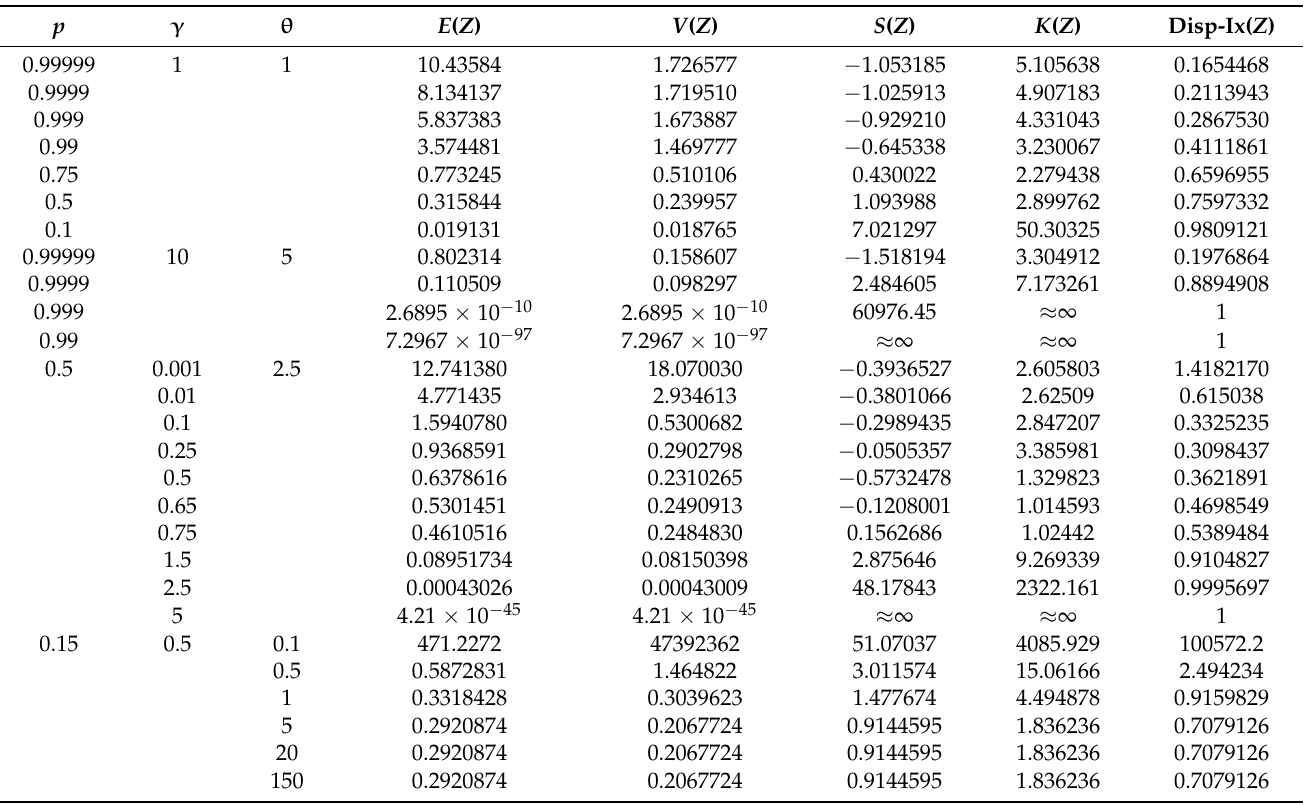
Table 3. Numerical results for E ( Z ) , V ( Z ) , S ( Z ) , and K ( Z ) of the DEGW